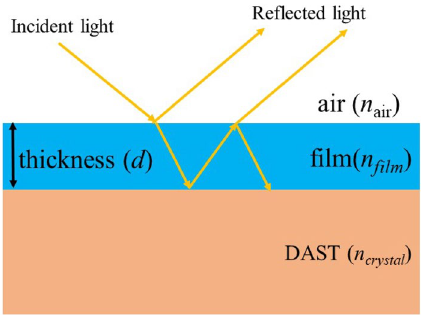
Figure 1. Schematic diagram of a thin film antireflection coating on the DAST